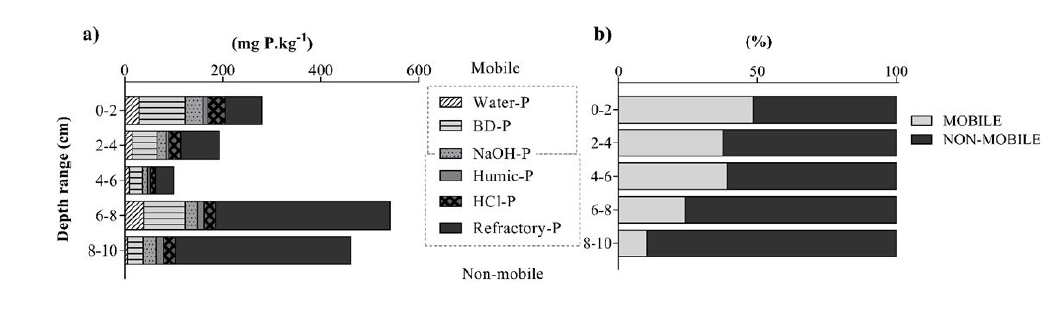
Figure 2. Content of P forms in the sediment profile (a), and the relative content of mobile and non-mobile pools (b).